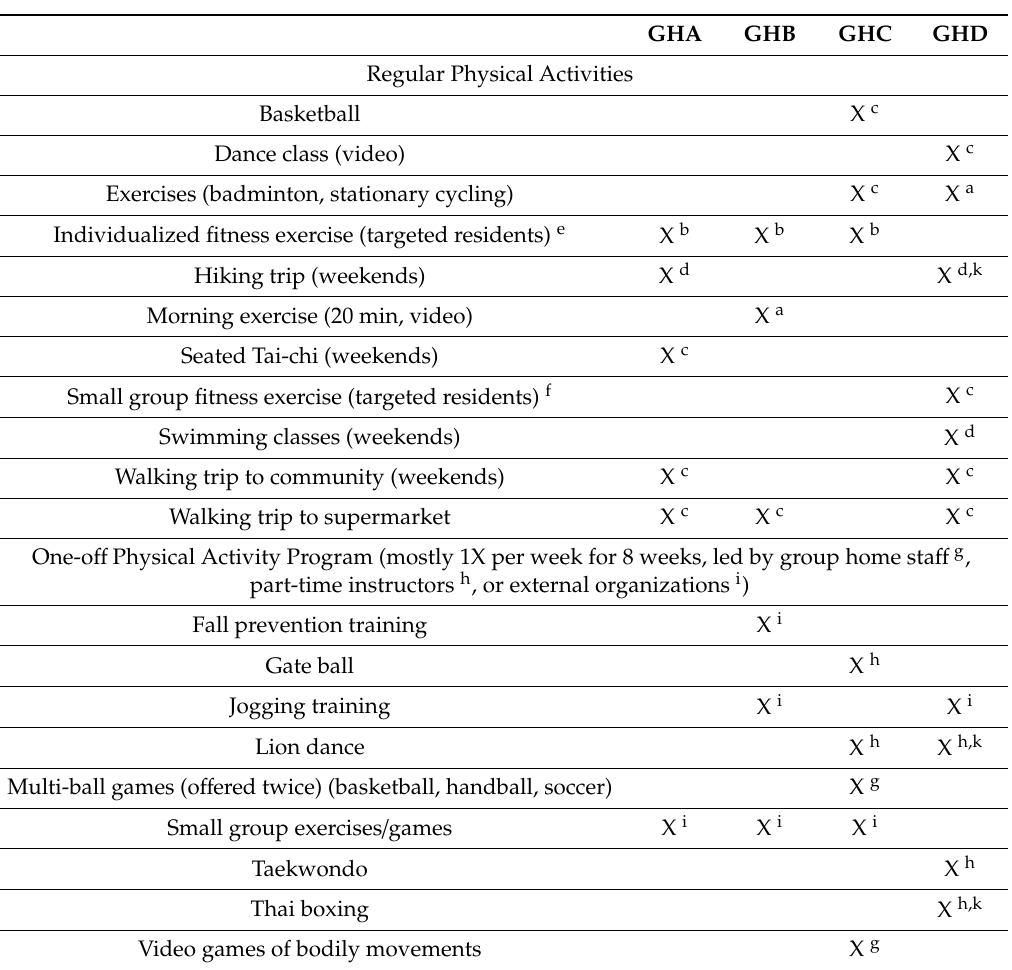
Table 2. List of physical activities o ff ered by group